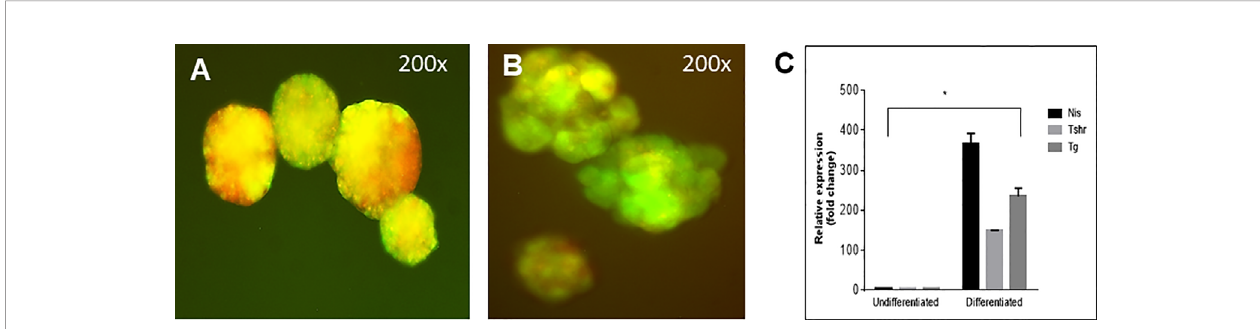
FIGURE 7 | Follicle structure and gene expression of labelled cells. (A) mES+/- cells formed embryoid bodies (EBs) when cultured in low attachment plates and (B) further differentiated into thyroid follicles in embedded Matrigel as observed with overlapping expression (yellow images) of Pax8-GFP and Nkx2-1mCherry. (C) qPCR data showed signi fi cantly enhanced expression of Tg, TSHR and NIS in these thyroid follicular cells compared to the undifferentiated cells (*P <